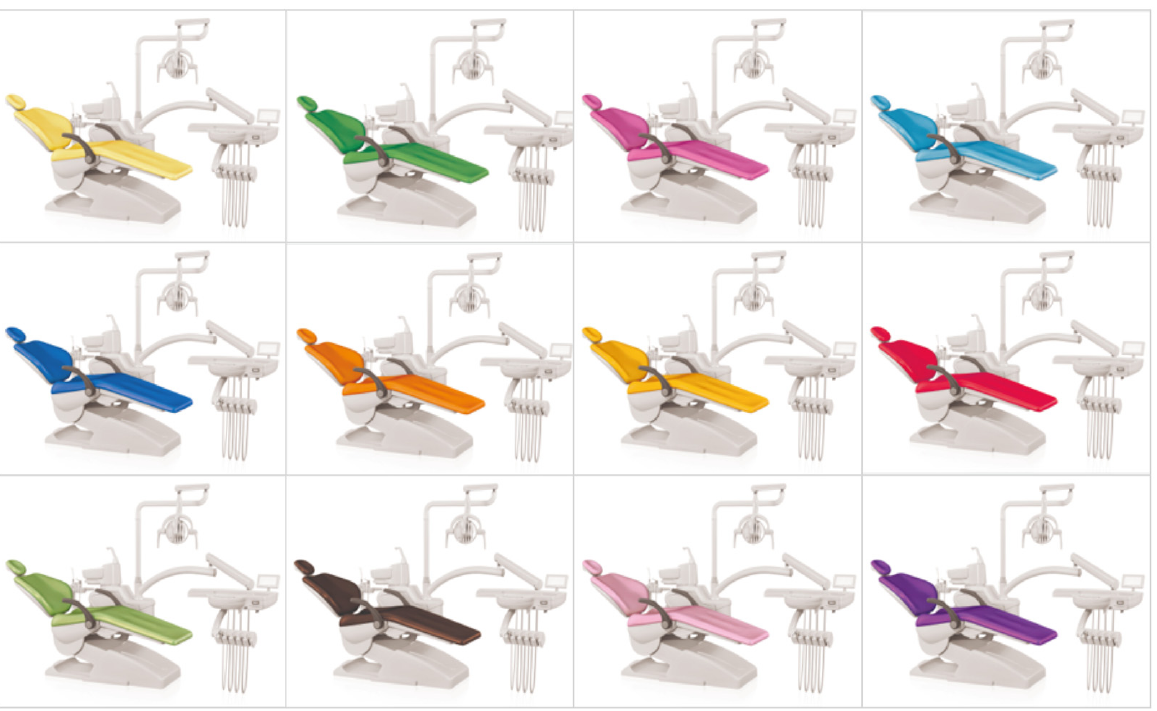
Figure 2. Color set of dental unit chair.